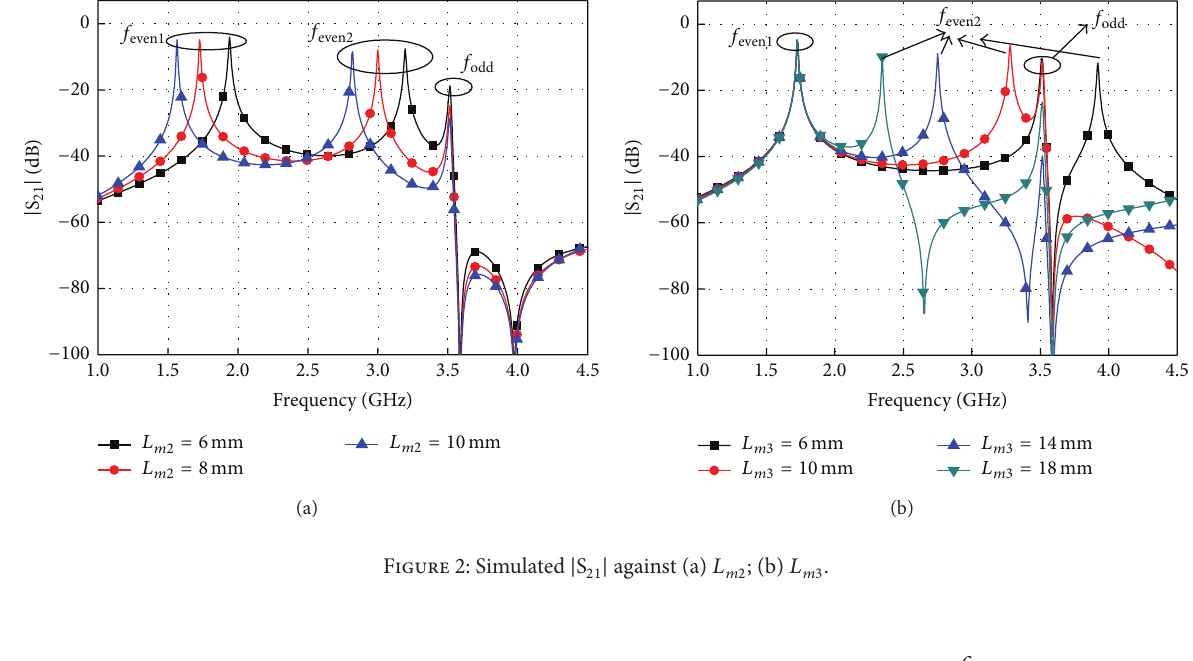
Figure 2: Simulated | S 21 | against (a) 𝐿 𝑚2 ; (b) 𝐿 𝑚3